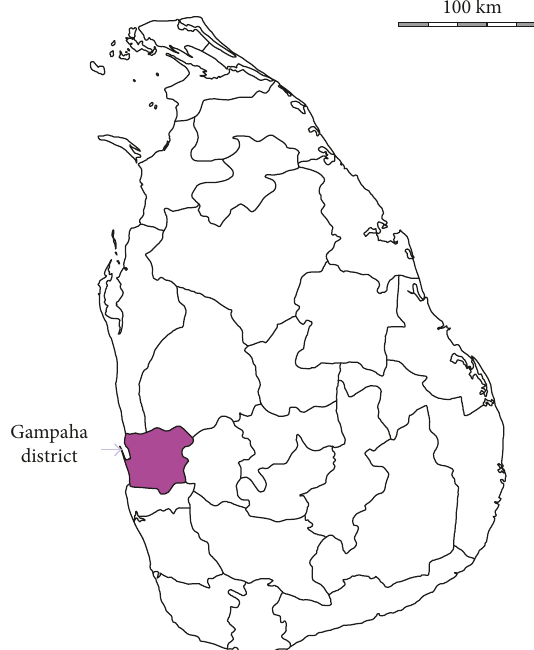
Figure 1: Location of Gampaha